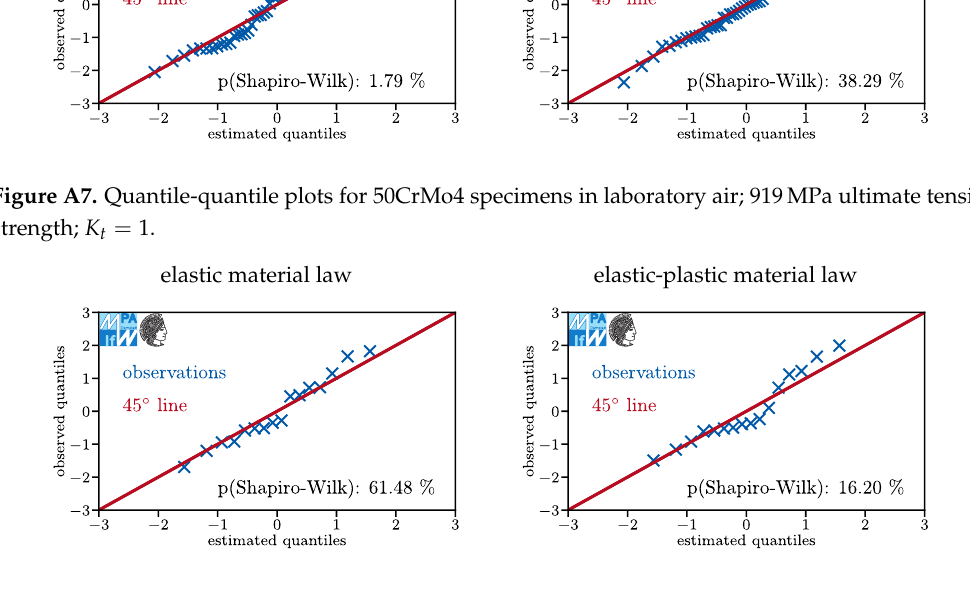
Figure A8. Quantile-quantile plots for 50CrMo4 specimens in laboratory air; 919MPa ultimate tensile strength; K t =